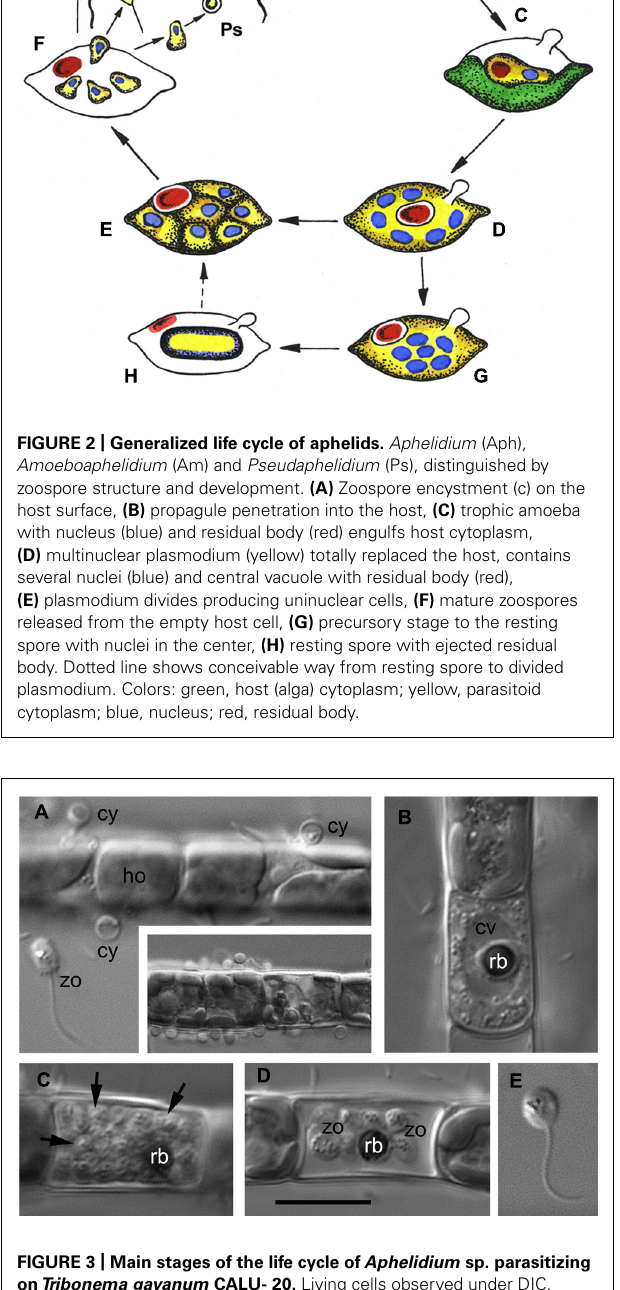
FIGURE 3 | Main stages of the life cycle of Aphelidium sp. parasitizing on Tribonema gayanum CALU- 20. Living cells observed under DIC. (A) Zoospore (zo) before attachment to the host (ho) and cysts (cy) on the surface of Tribonema filament. Insert – multiple infection at lower magnification. (B) Plasmodium with central vacuole (cv) and residual body (rb). (C) multicellular stage of parasitoid with rb at the periphery (arrows show separate cells). (D) mature zoospores with flagella and residual body in the empty host cell. (E) Free-swimming zoospore at high magnification. Scale bar: A–D , 10 μ m, insertion in A , 15 μ m, E , 8 μ m.